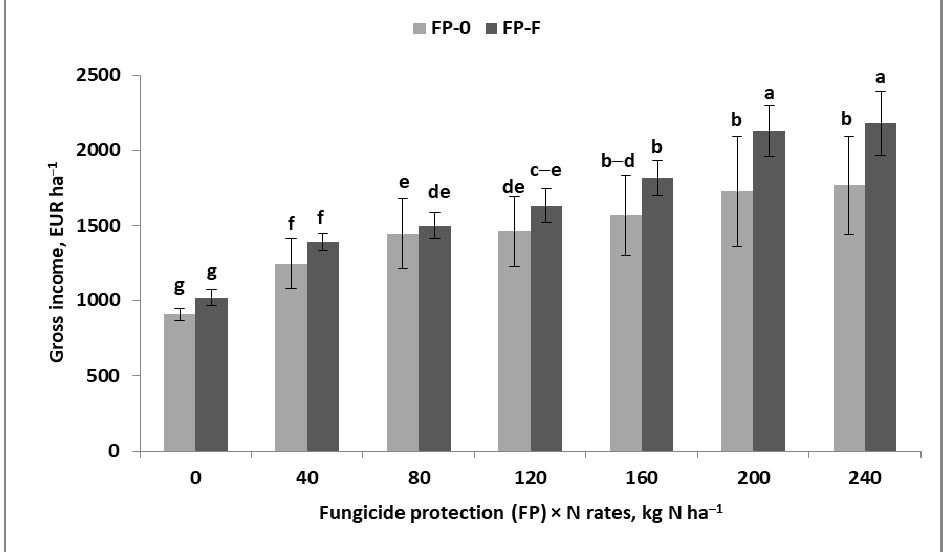
Figure 3. Effect of winter wheat protection with fungicides and rates of fertiliser nitrogen on gross income. Similar letters in the column means a lack of significant differences using Tukey’s test; the vertical bar in the column refers to the standard error of the mean. Table 3. Economic indicators—results for 2014 and 2015 for prices and costs from